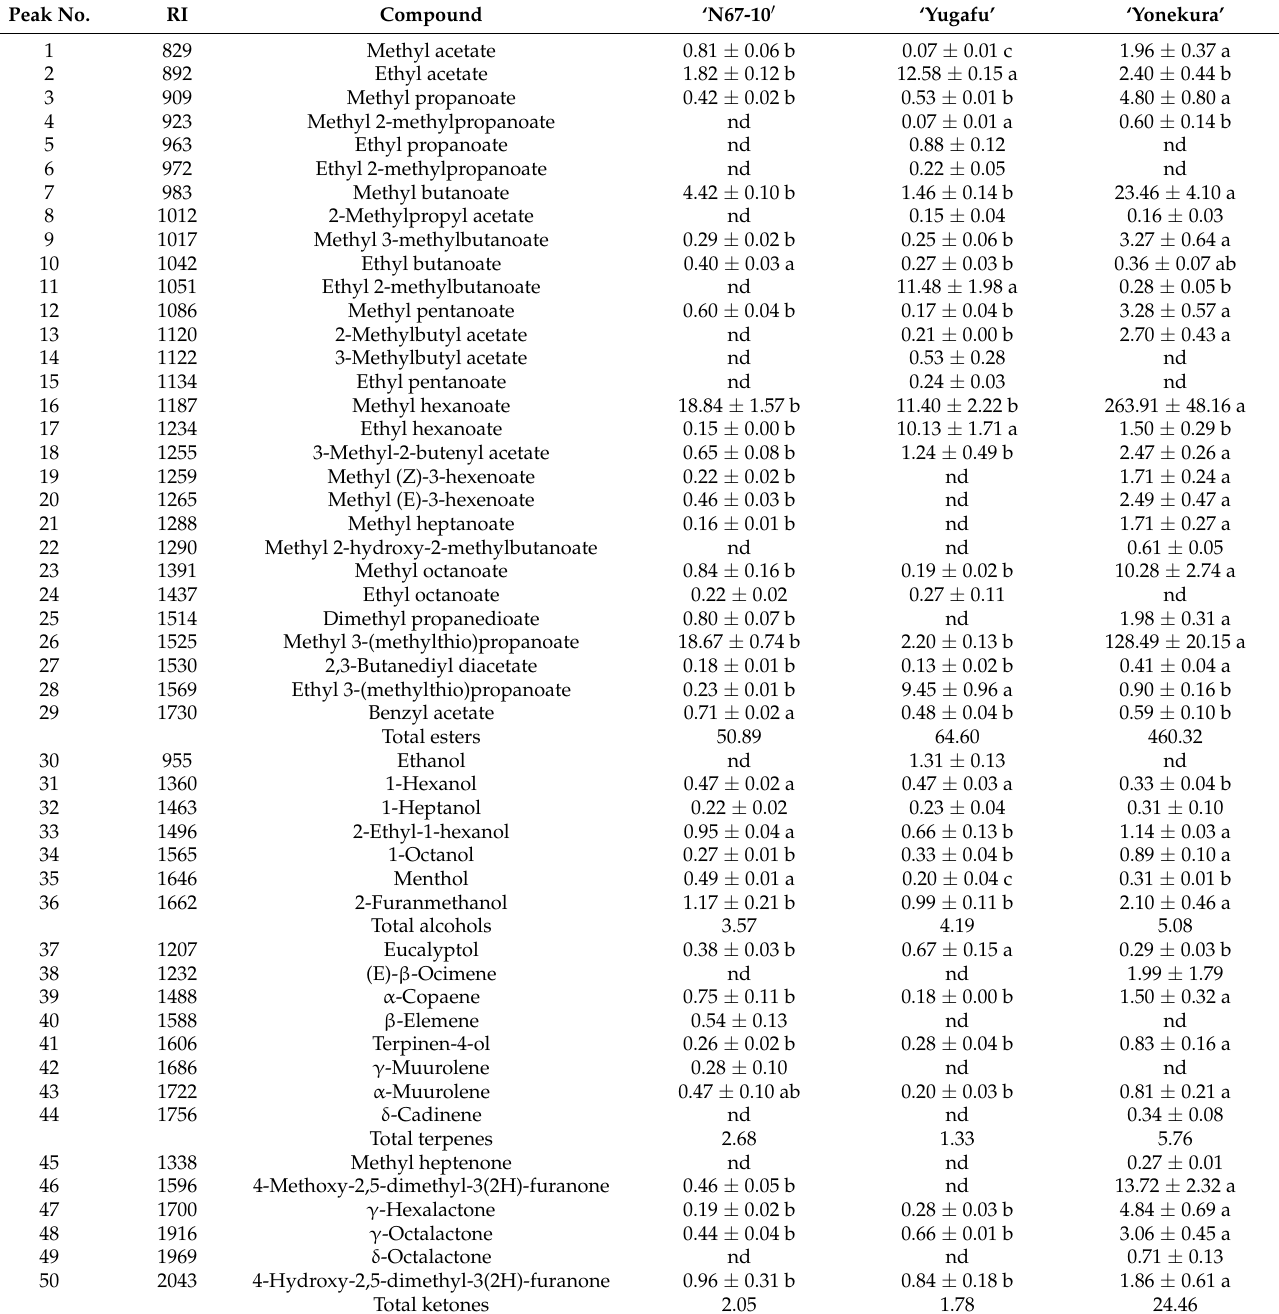
Table 2. Free volatile components of Okinawan pineapple ( µ g/100